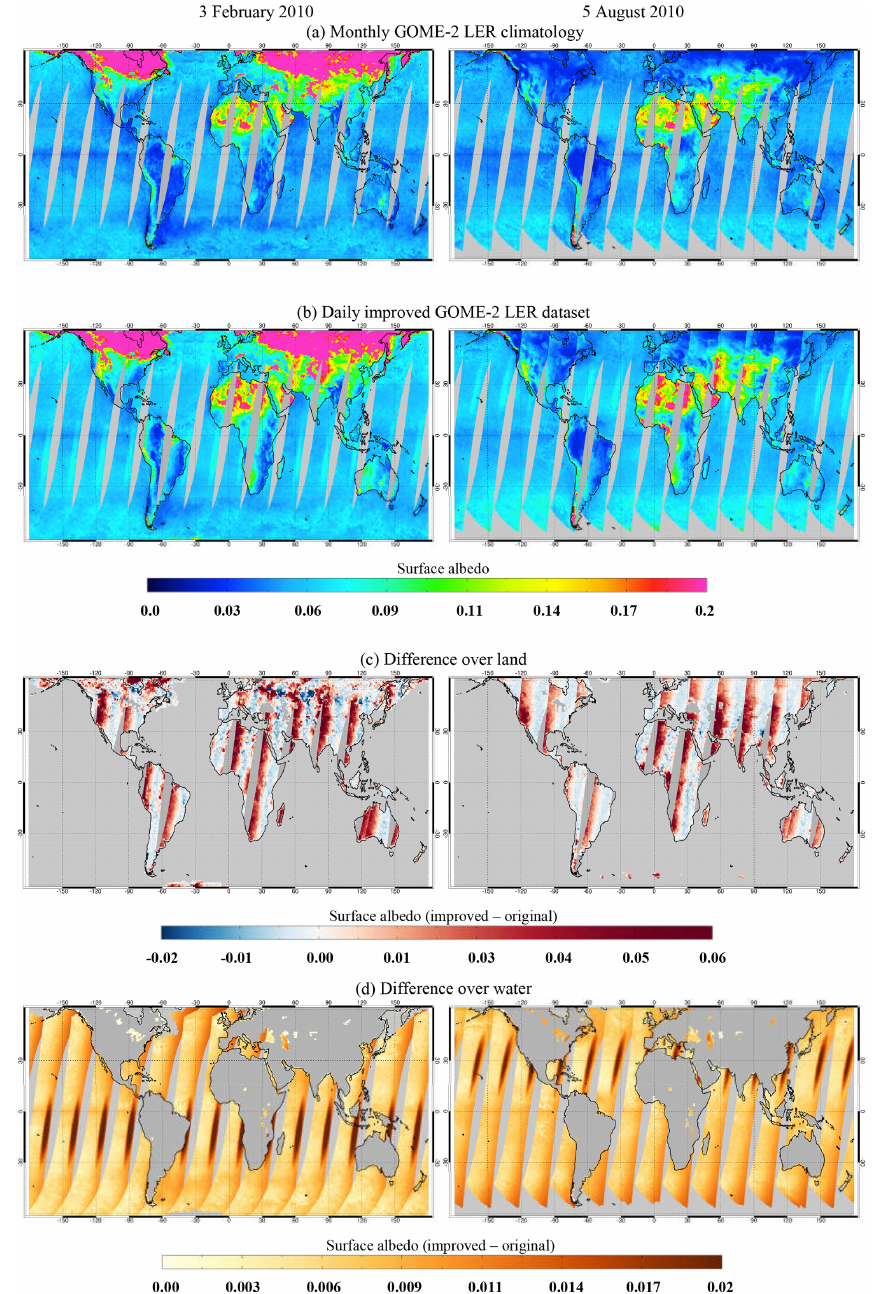
Figure 1. Map of GOME-2 surface LER climatology (Tilstra et al., 2017) version 3.1 in February and August (a) , improved GOME-2 surface LER data taking the direction dependency on 3 February and 5 August 2010 into account (b) , and their differences over land (c) and over water (d) . The improvements are described in Sect. 3.1.1 for land and in Sect. 3.1.2 for water.